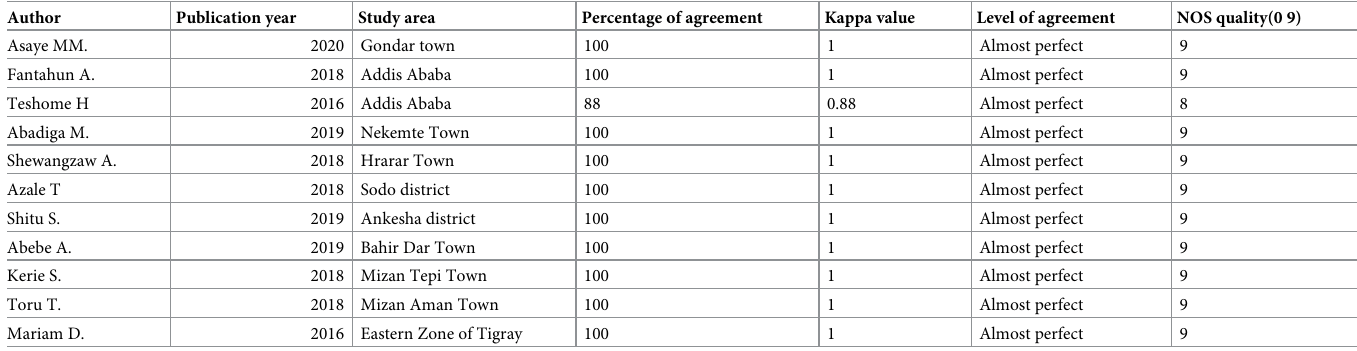
Table 2. The quality and agreed level of bias and level of agreement on the method qualities included articles in a meta-analysis based on sample, outcome, objec- tive, responses rate and analysis